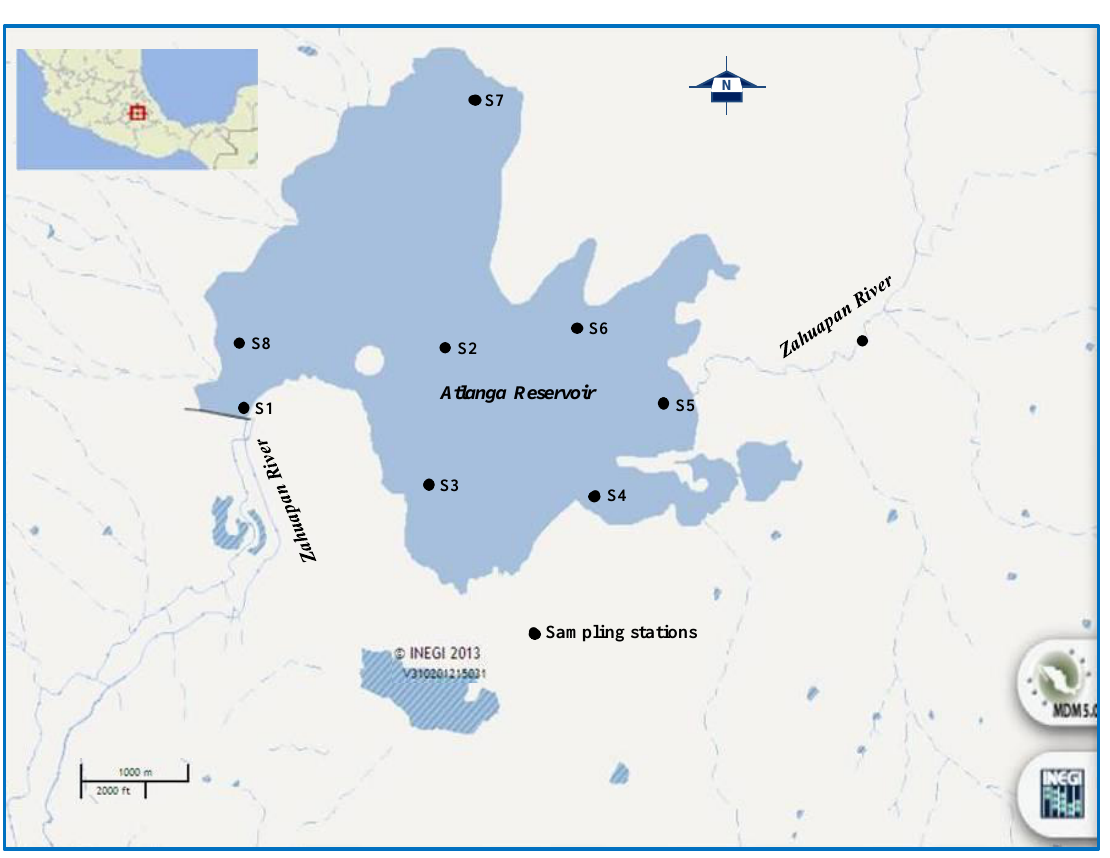
Figure 1. Study area localization and sampling stations in the major tributary (Zahuapan River) and the Atlanga Reservoir. Modified from INEGI